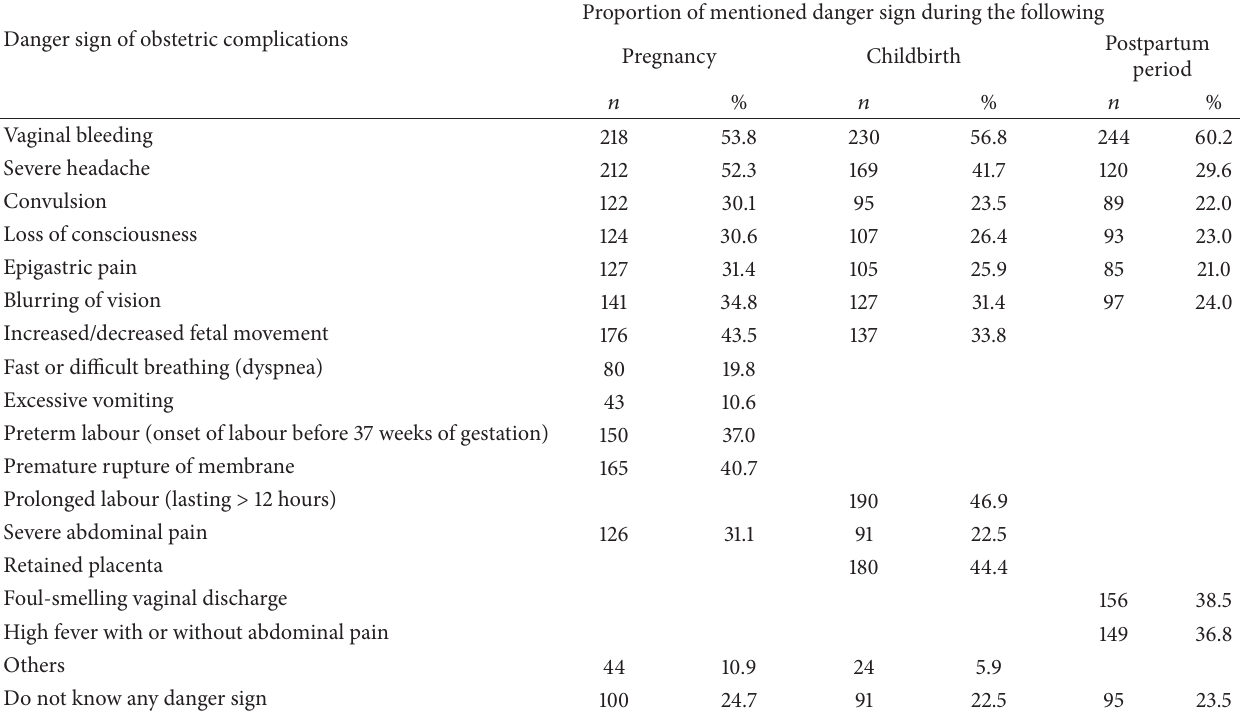
Table 3: Proportion of recalled danger signs of obstetric complications among postnatal mothers of Mechekel district health centers, East Gojjam zone, Northwest Ethiopia, 2014 ( 𝑛 = 405